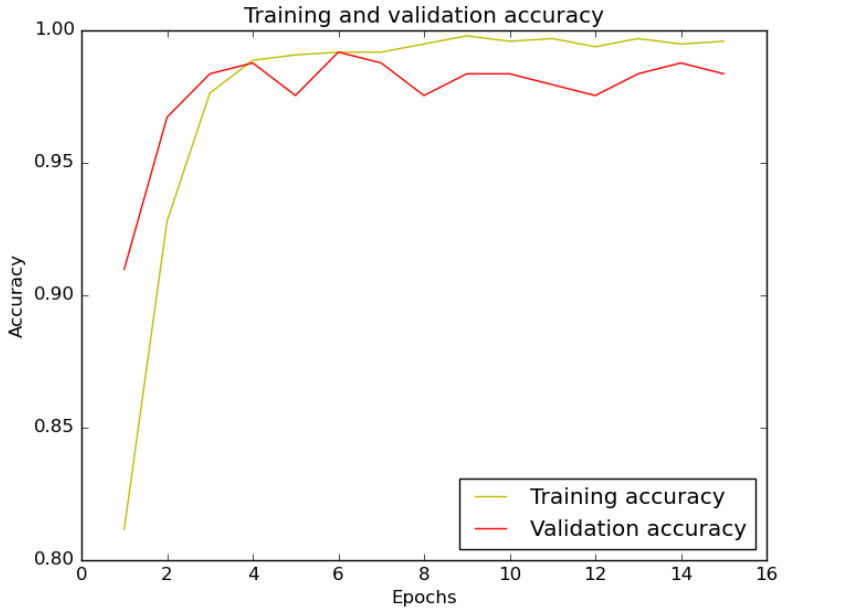
Figure 13. Accuracy plot for the binary classification model. The receiver operating characteristic curve (ROC) for a binary classification model is shown in Figure 14. ROC is a receiver operating curve, which is one of the model’s measuring metrics. The area under curve can be defined as the AUC that indicates the performance of the model. It is a graph that shows how the true positive rate (TPR) and the false positive rate (FPR) are related. For the studied binary classification model, the ROC was 100%.